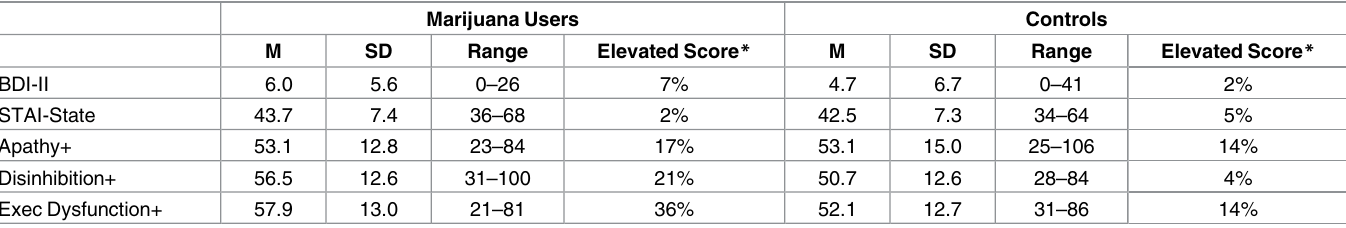
Table 2. Clinical Levels of Symptom Scales.